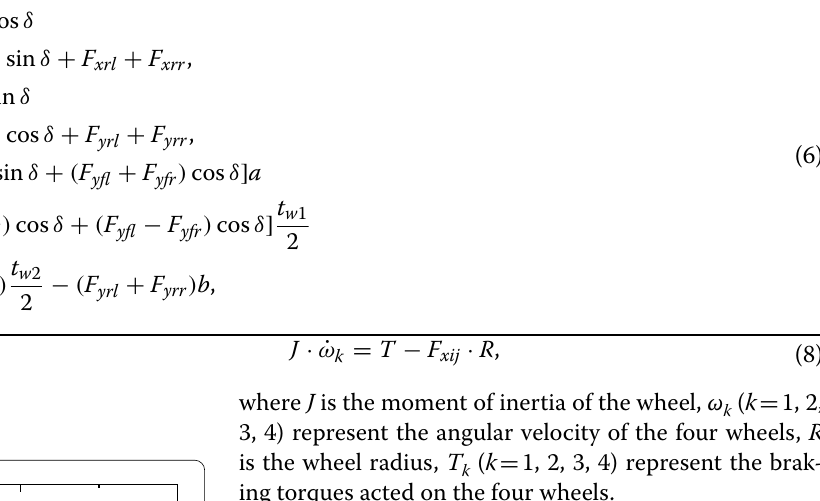
Hierarchical control framework ANFTSM controller